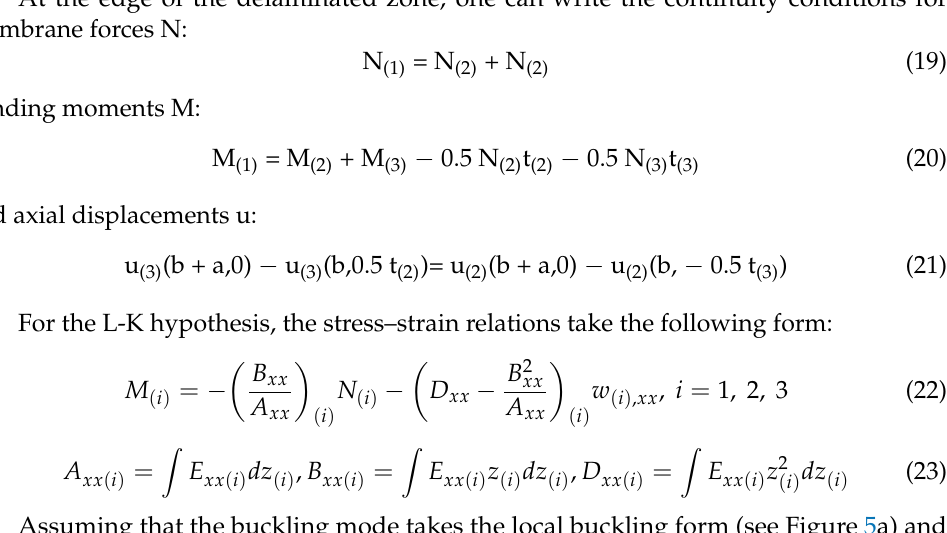
Figure 9. The cross-section of the plate with the delamination a (u (i) = u 1(i), w (i) = u 3(i) , x = ξ 1 ). At the edge of the delaminated zone, one can write the continuity conditions